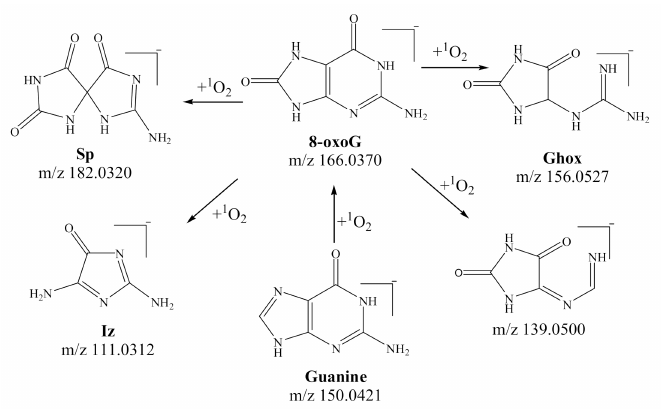
Figure 1. Proposed oxidative products of guanine induced by singlet oxygen in the literature (quoted from